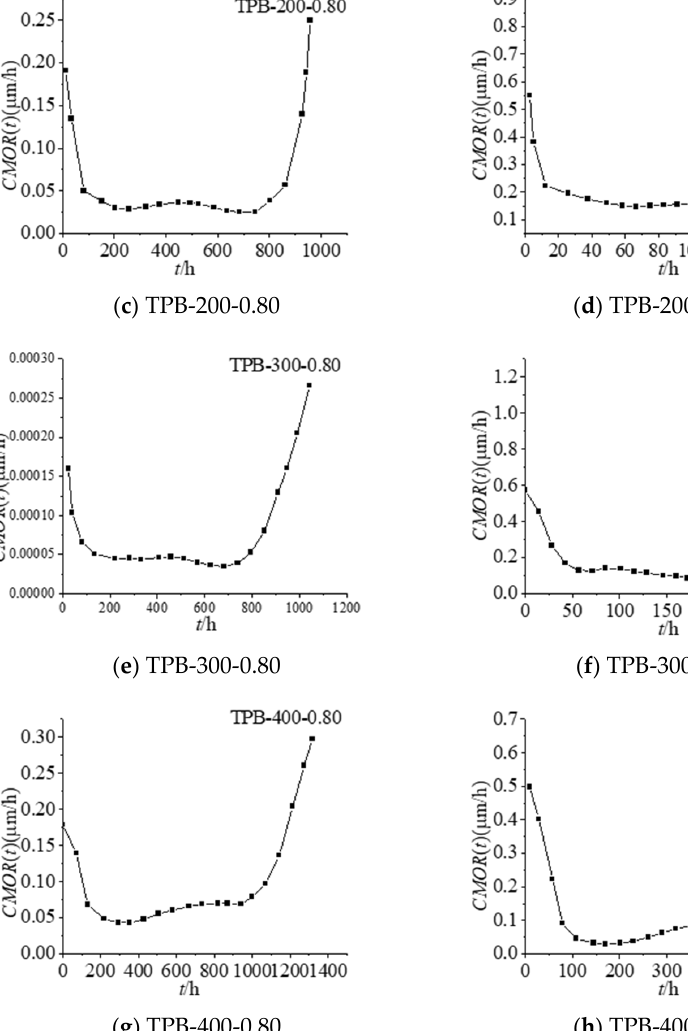
Figure 1. Time-dependent fracture curves CMOR(t)-t . CMOR(t) denotes the slope of the CMOD(t)-t curve. Similar to the CMOD(t)-t curve, the CMOR(t)-t curve exhibits a three-stage feature. In the first deceleration stage, CMOR(t) decreased over time. The second stage could be characterised by stable propagation of the crack, and CMOR(t) kept at a relatively stable level along with time. Finally, the specimen entered the instability stage, namely, the third acceleration stage, when the time-dependent CMOR(t) increased significantly fast with time until the specimen was destroyed. Researchers [20] have reported that the crack expansion throughout the three stages can be attributed to two factors according to the virtual crack model. One factor is the creep behaviour of matrix materials outside the fracture process zone, and the other factor is the time-dependent softening behaviour of virtual cracks in the fracture process zone. The crack growth in the first stage is caused by matrix material creep outside the fracture process zone. The aforementioned factors act synergistically to promote crack propagation in the second stage. The time-dependent softening behaviour of virtual cracks in the fracture process zone is the determinant of crack propagation features in the third stage. In the third stage, the fracture process zone is formed and it is difficult to dissipate energy. As a result, the crack length increases quickly, eventually leading to specimen failure. As demonstrated by the variation of the time-dependent CMOR(t) with time, there was a correlation between the concrete specimen crack propagation behaviour under constant load with the time